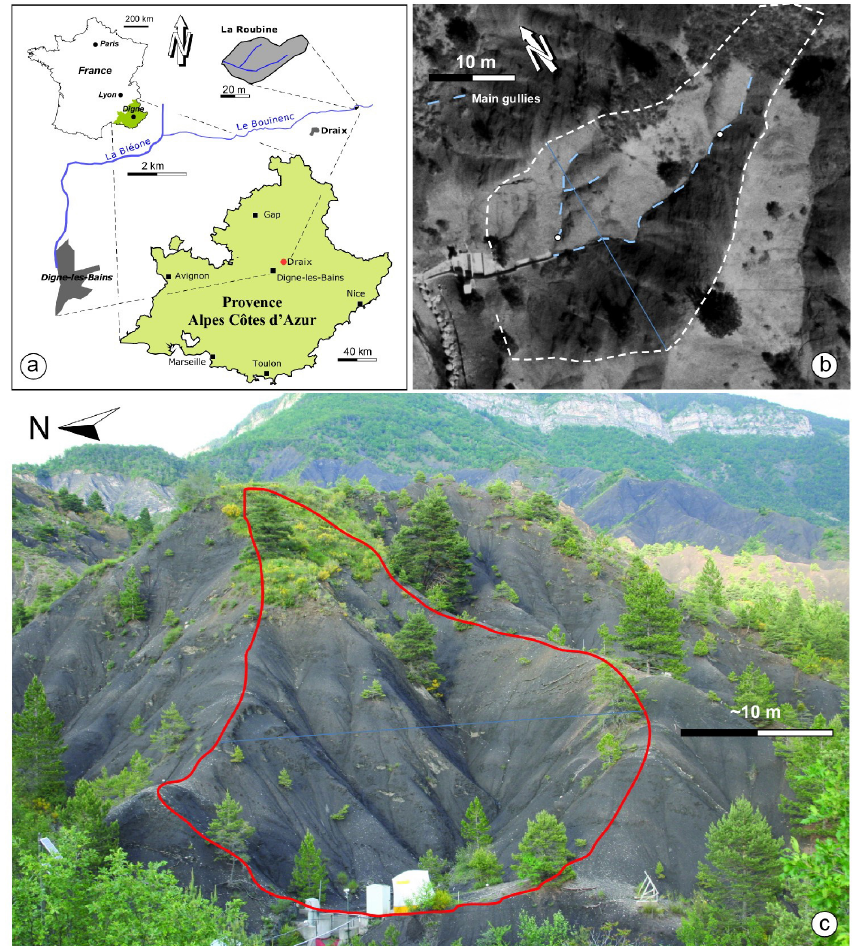
Figure 1. Location and picture of La Roubine. (a) Location of La Roubine catchment. (b) Aerial image of La Roubine. (c) Photograph of the Roubine catchment (1 June 2011) with the contours indicated in red line. Foreground: La Roubine catchment characterized by a typical badland morphology, many small-scale rills and gullies, steep slopes, and scarce vegetation. The catchment outlet is located at the western extremity with the sediment trap and the limnigraph. Background: surrounding badlands and limestone